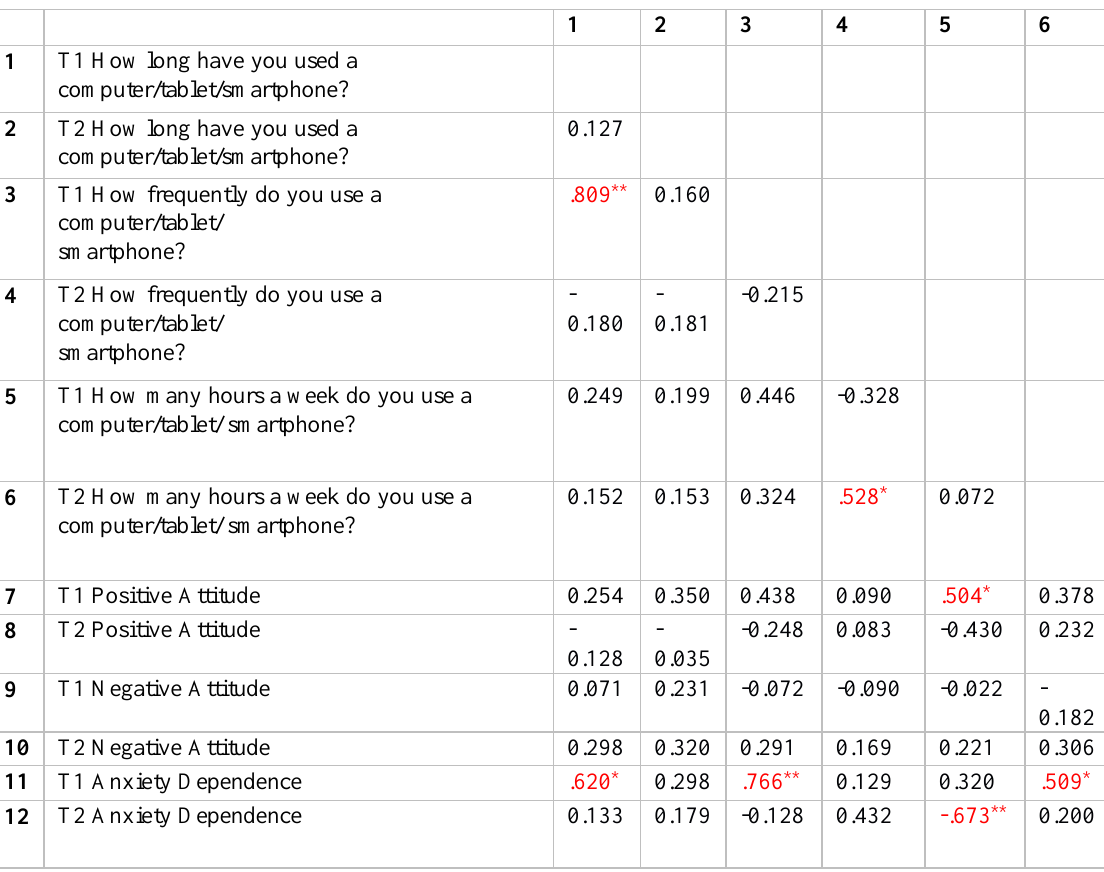
Table 4: Do participants’ experience and usage of technology relate to their attitudes towards